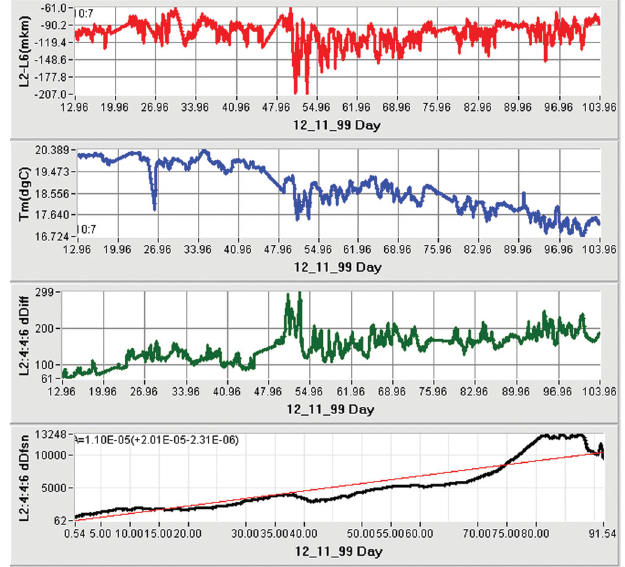
FIG. 33. (Color) 91 days data records starting November 12, 1999 from the PW studies: (top to bottom) the level difference between probes #2 and #6 120 (vertical scale of about 150 (cid:7) m ), mean temperature in the tunnel (vertical scale of 3 : 5 (cid:9) C ), the (see in the text, scale 240 (cid:7) m ), second level difference SD 2446 for intervals and variance of the second level difference SD 2446 of up to 91 days (from Ref.